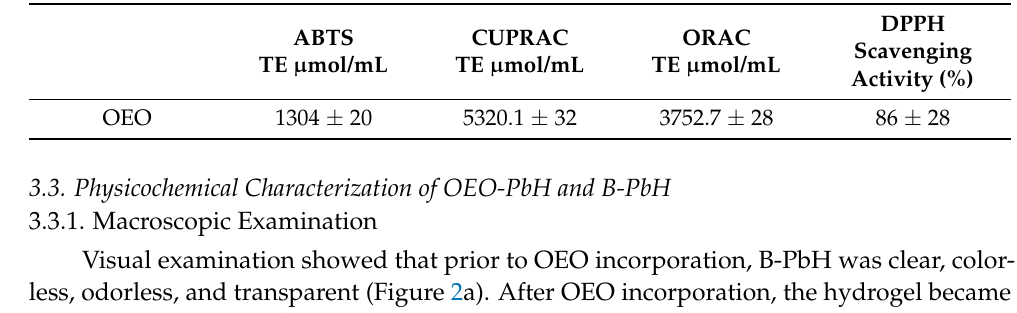
Table 2. The antioxidant activity of OEO by four different methods.